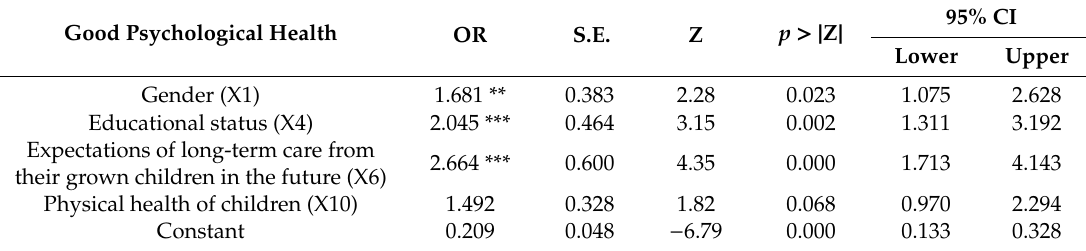
Table A6. Logistic regression results in the eighth step (full